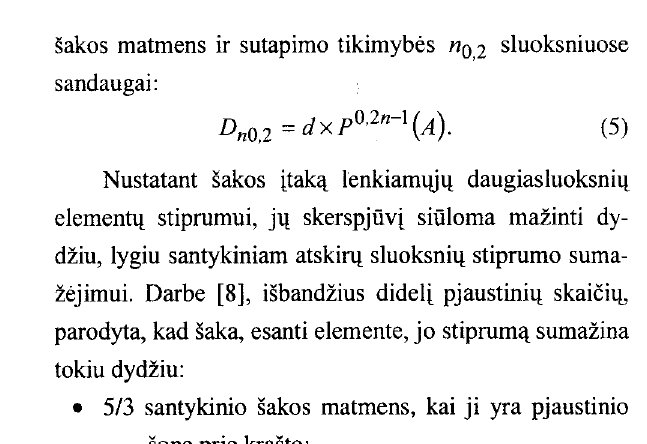
Table 1. Factors estimating the influence of knots on the strength of multilayered bending members